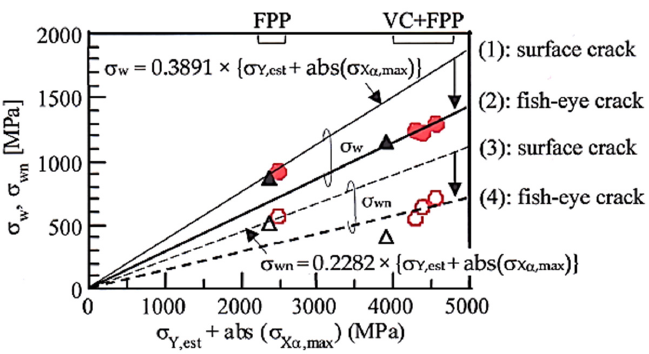
Figure 20. Relationships between smooth and fatigue limits ( σ w , σ wn ) and the sum of estimated yield stress and the absolute value of maximum compressive residual stress { σ Y,est + abs( σ X α ,max )} of smooth (solid marks) and notched (open marks) specimens in 0.2%C–1.5%Si–1.5%Mn–1.0%Cr– 0.05%Nb TM ( ● ○ ) and JIS-SNCM420 ( ▲△ ) steels subjected to only fine particle peening (FPP) with an arc height of 0.21 mm(N) after the heat-treatment (DQ-P process, T p = 180 ° C)) and vacuum carburization under various carbon potentials ( C P = 0.2 to 0.8 mass%) and subsequent FPP (VC+FPP). Lines (1) and (3) denote the fatigue limits of the smooth and notched specimens subjected to FPP treatment, respectively. Lines (2) and (4) refer to the fatigue limits of the smooth and notched specimens subjected to VC+FPP treatment [148]. Reprinted with permission from Taylor & Francis: Mater. Sci. Technol., Copyright 2021.